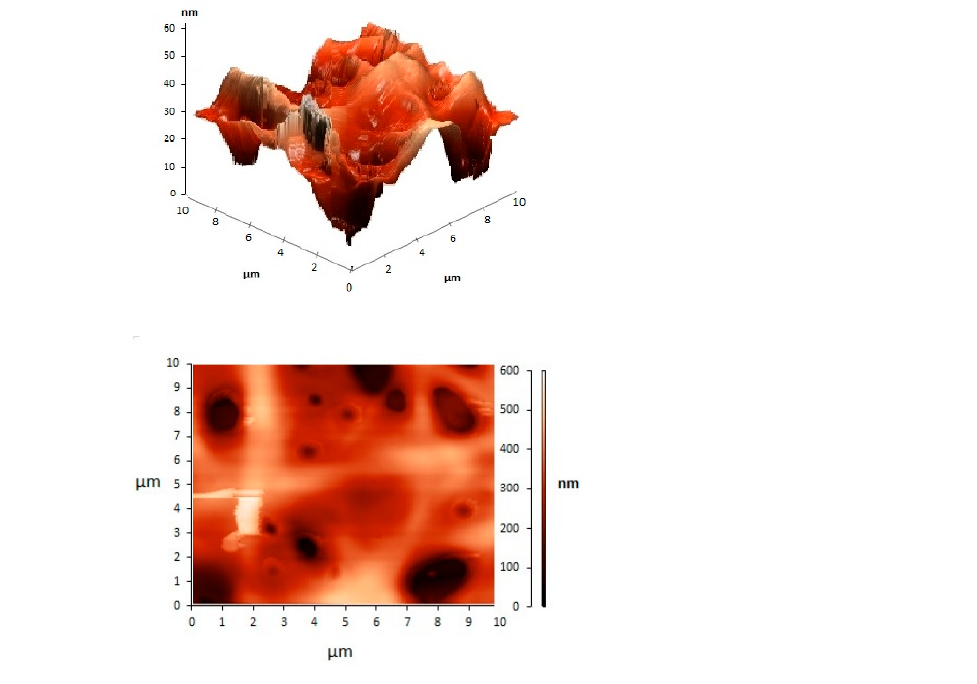
Figure 8. Atomic force microscopy (AFM) topography image of glutaraldehyde (GTA) cross-linked Bup/PVP/PVA nanofiber mats.